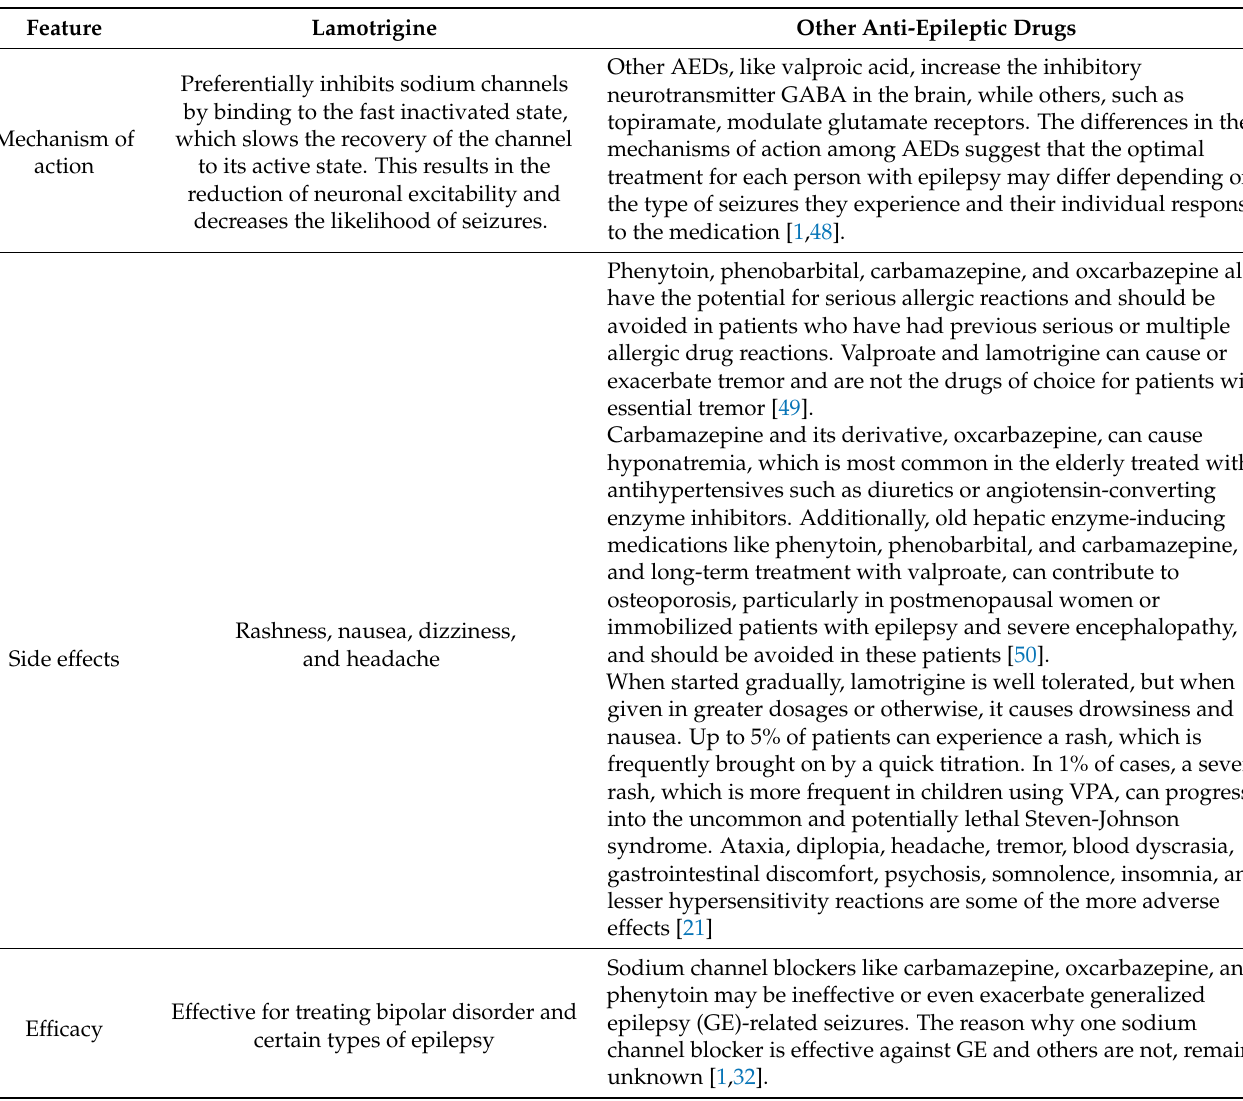
Table 1. Comparison of LTG with other anti-epileptic